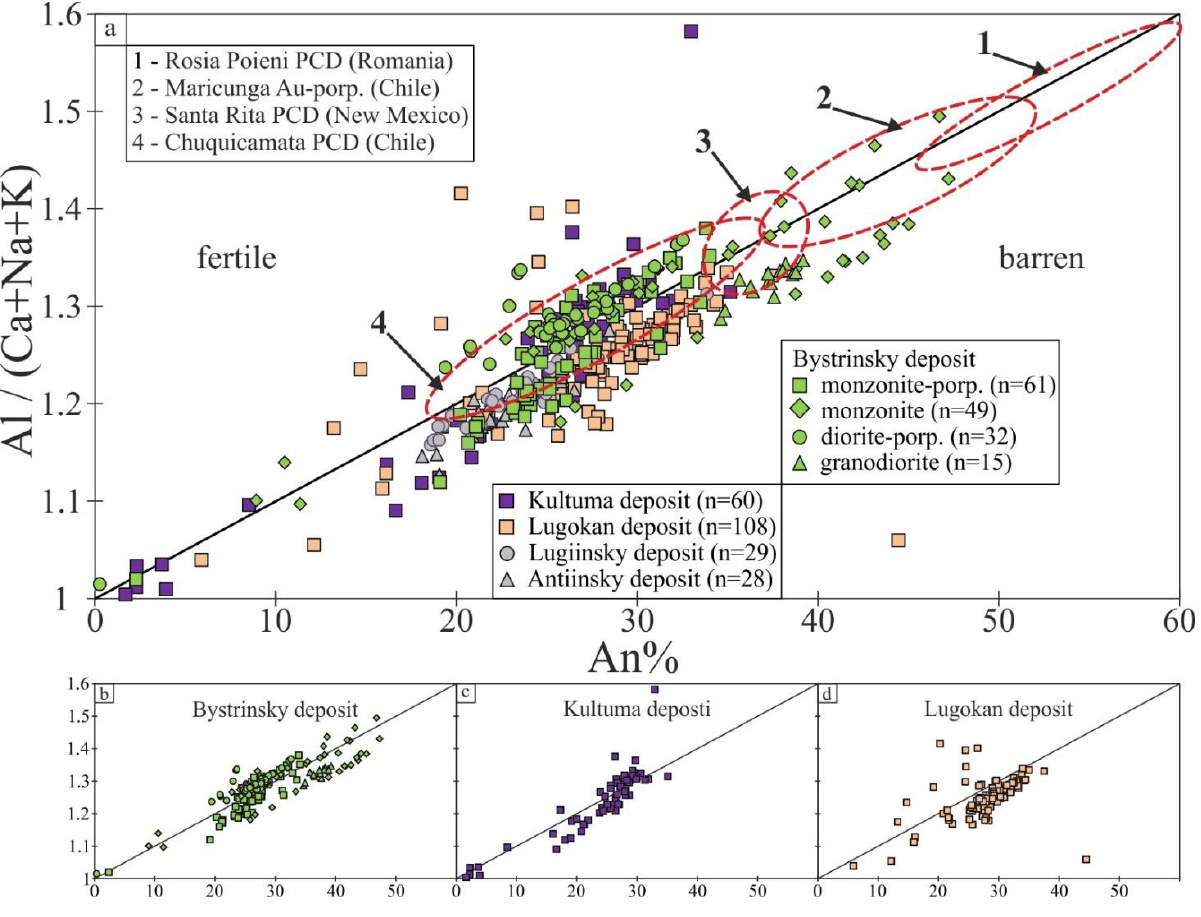
Figure 9. Discrimination diagram to distinguish ore-bearing (fertile) magmatic rocks from barren ones. ( a ) — summary diagram for the deposits of Eastern Transbaikalia and the World ; ( b ) — plagio- ( a )—summary diagram for the deposits of Eastern Transbaikalia and the World; ( b )—plagioclase clase plots for the Bystrinsky deposit; ( c ) — plagioclase plots for the Kultuma deposit; ( d ) — plagio- plots for the Bystrinsky deposit; ( c )—plagioclase plots for the Kultuma deposit; ( d )—plagioclase plots clase plots for the Lugokan deposit. for the Lugokan